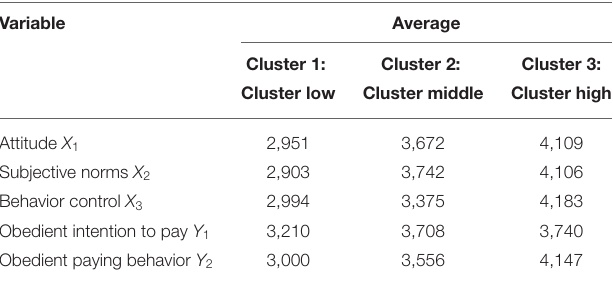
TABLE 8 | Average score of each cluster.